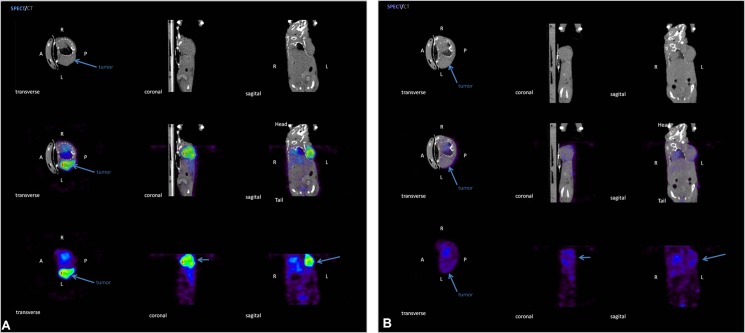
Representative transverse, coronal, and sagittal views from SPECT, micro-CT, and fused SPECT/CT.Tumor-bearing mice were imaged 24 h after injection of (A) 74 MBq of Rebmab200-HYNIC-99mTc or (B) control IgG1 antibody. Arrows indicate tumor masses.